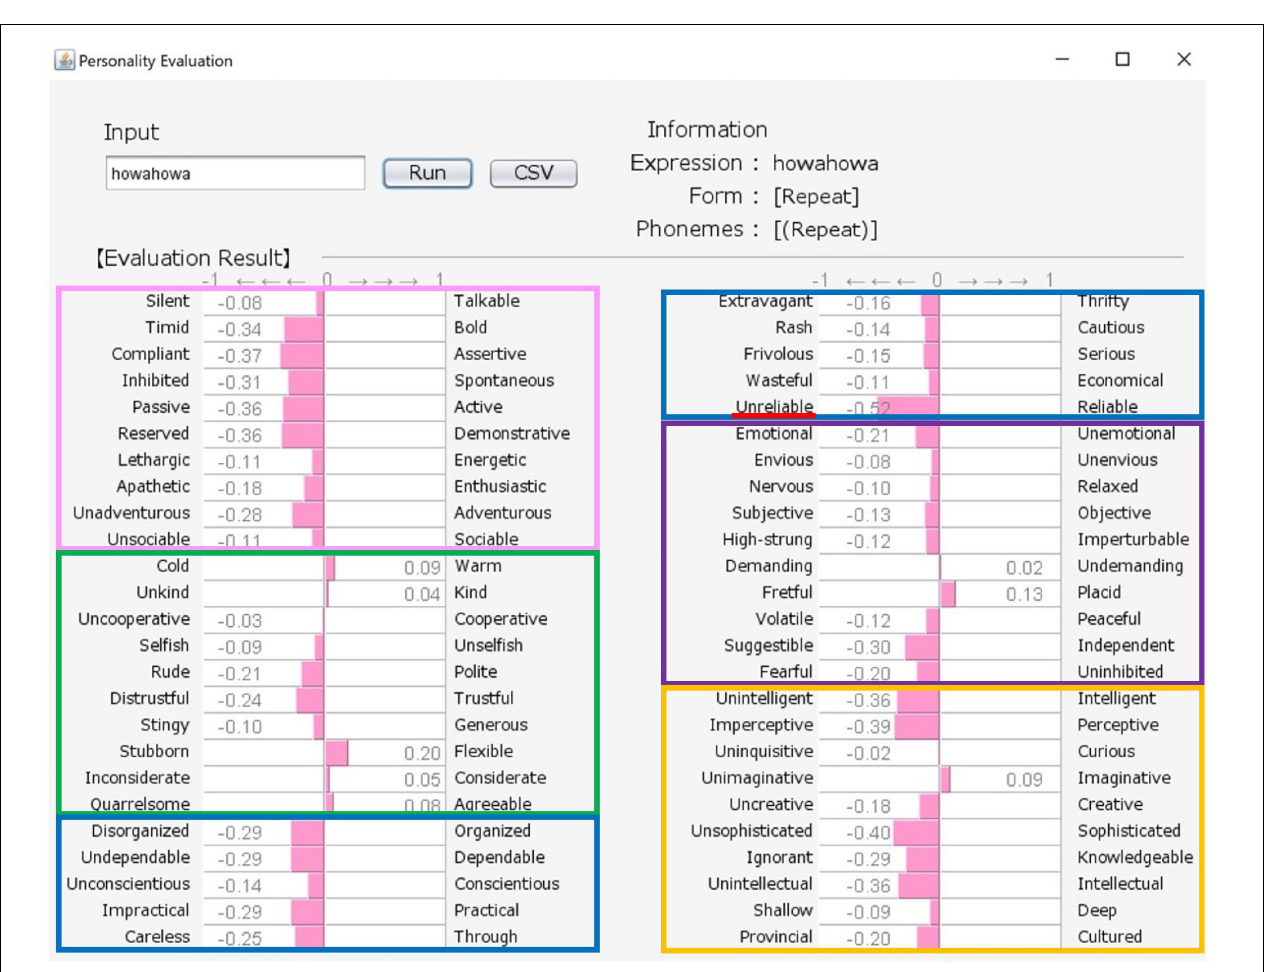
FIGURE 1 | Output for “howa-howa (nearly equal to fluffy)” personality (soft but unreliable). The pink, green, blue, purple, and orange frames indicate Extroversion, Agreeableness, Conscientiousness, Neuroticism, and Openness, respectively.